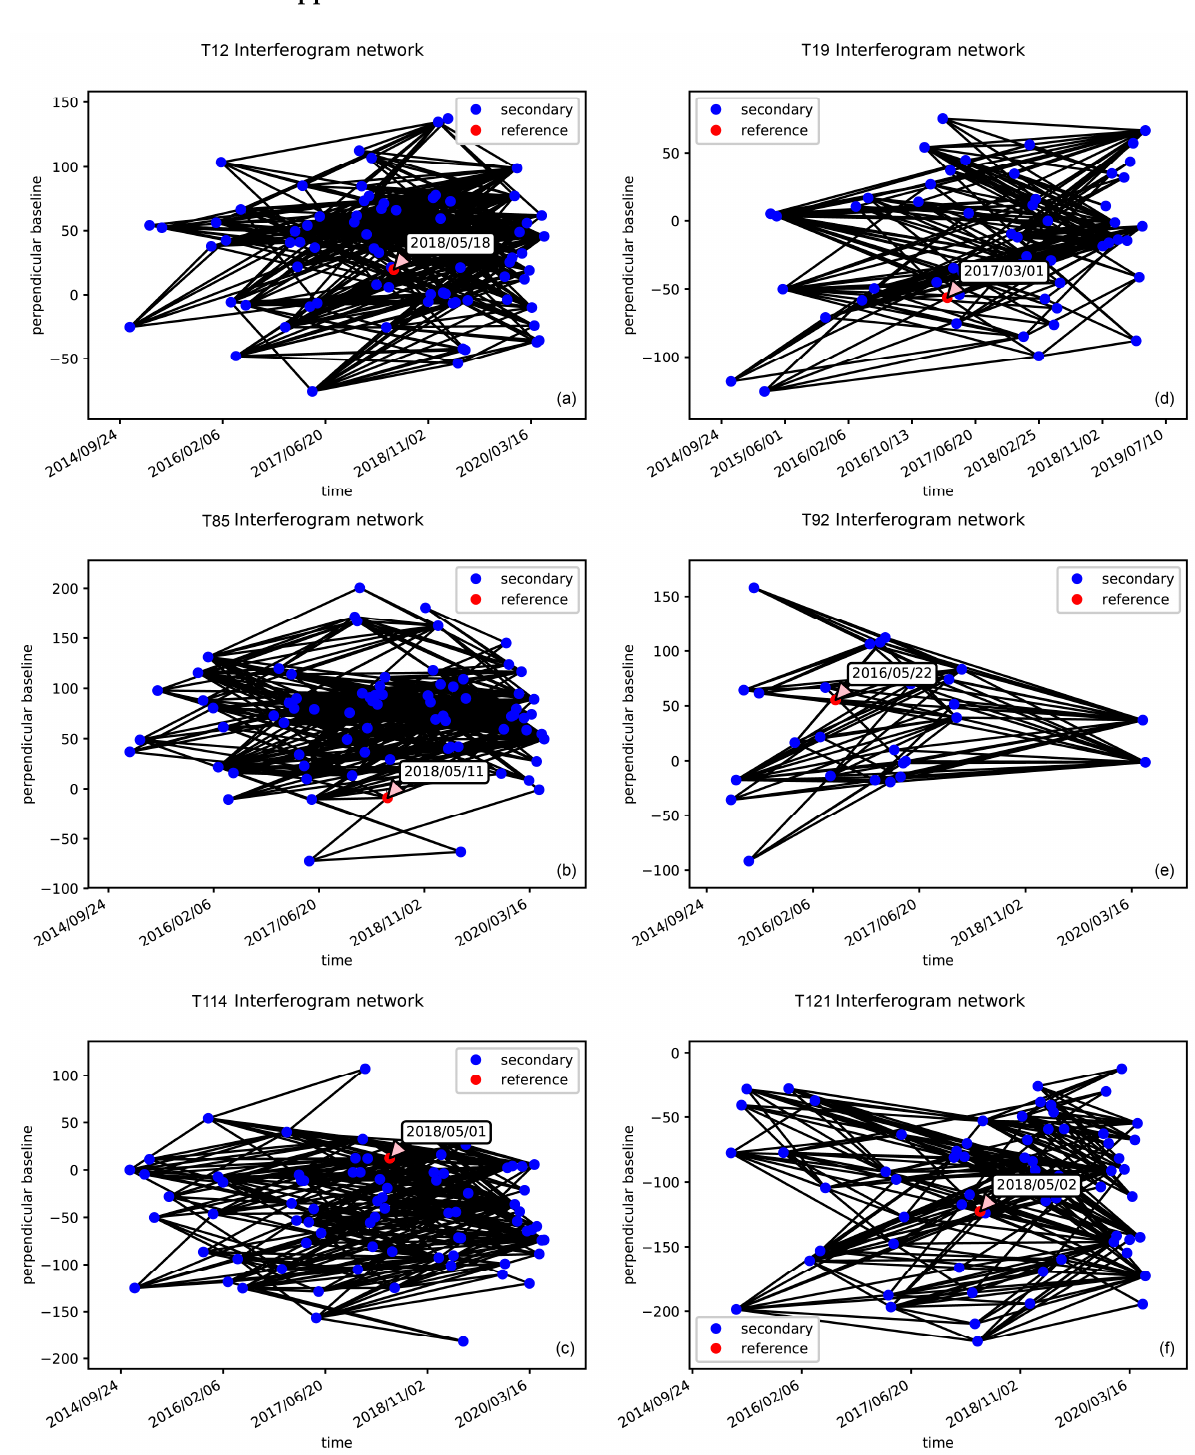
Figure A1. Computed interferograms for the six Sentinel-1 tracks. The reference images are shown with red dots.